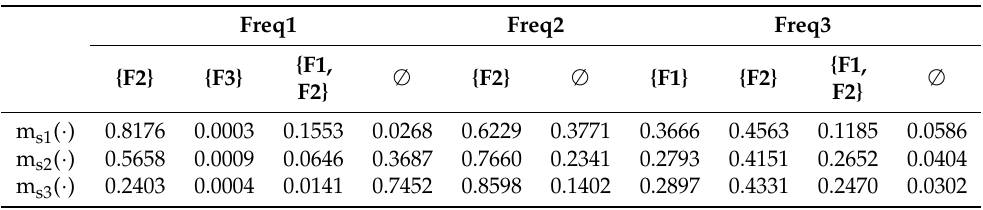
Table 4. Fault diagnosis data modeled as